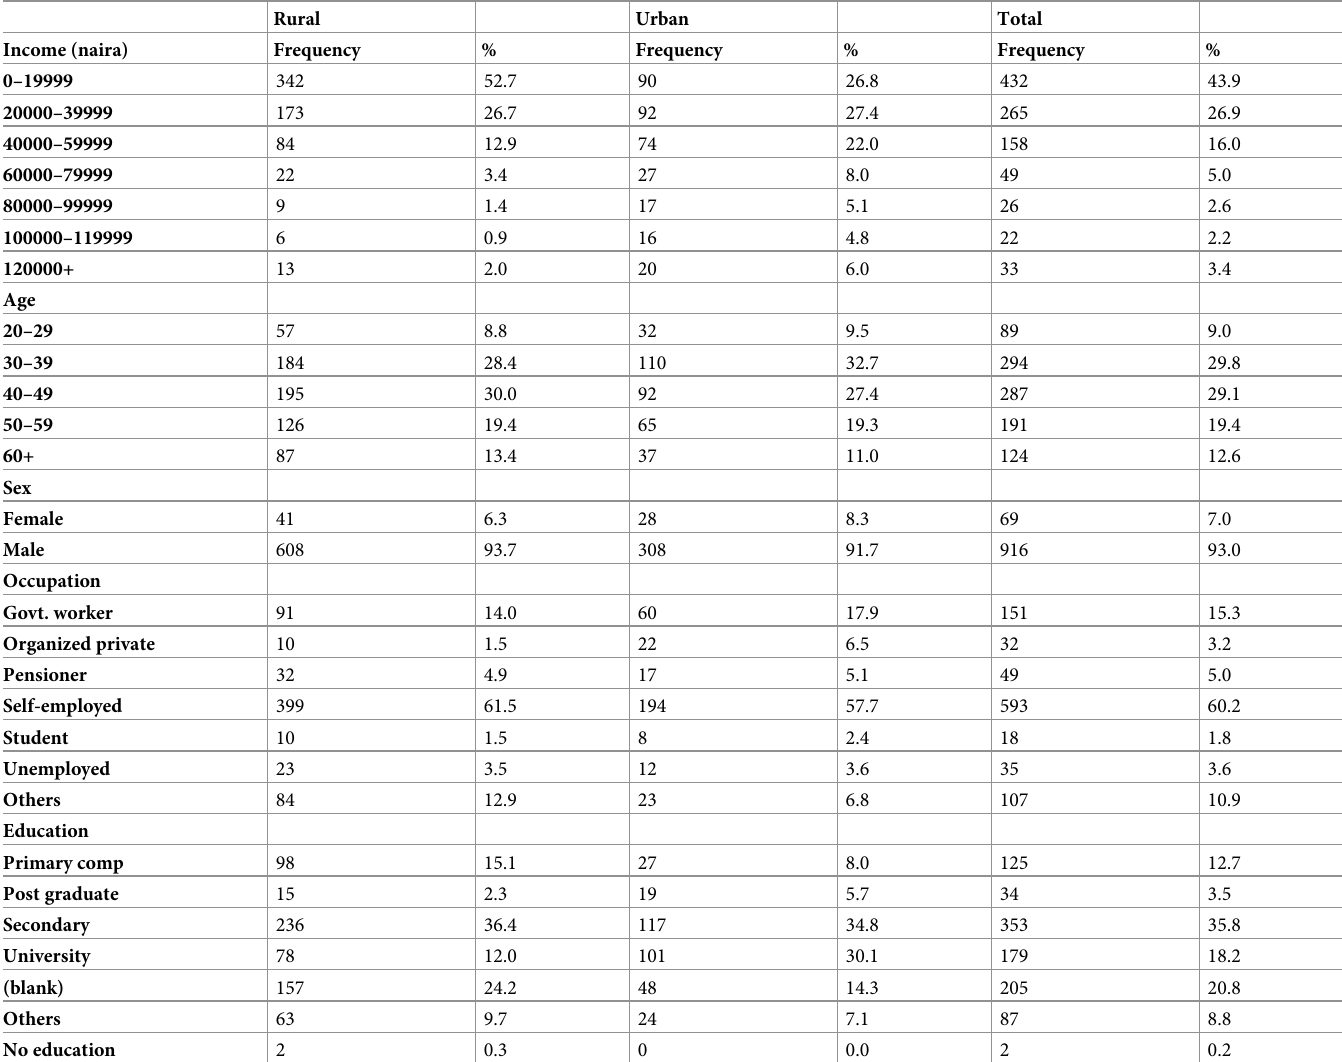
Table 3. Key socio-economic characteristics of respondents.